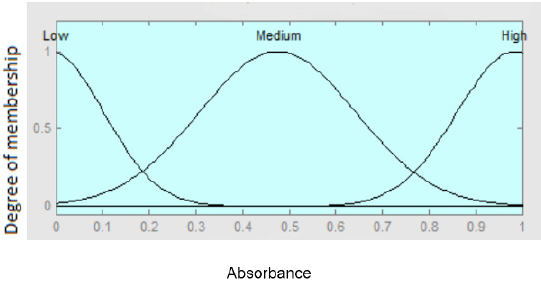
Figure 7. Membership function of absorbance as output